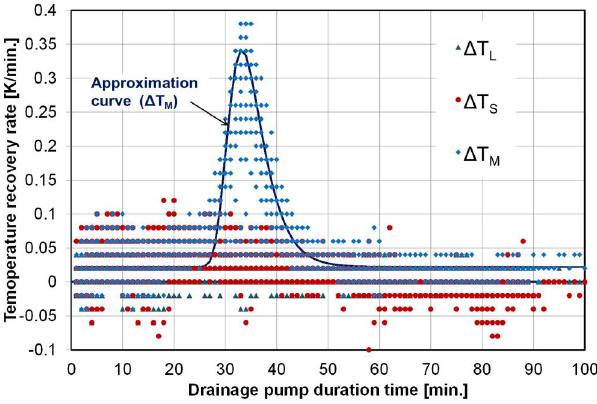
Figure 11. Change in the temperature recovery rate during the drainage pump operation.